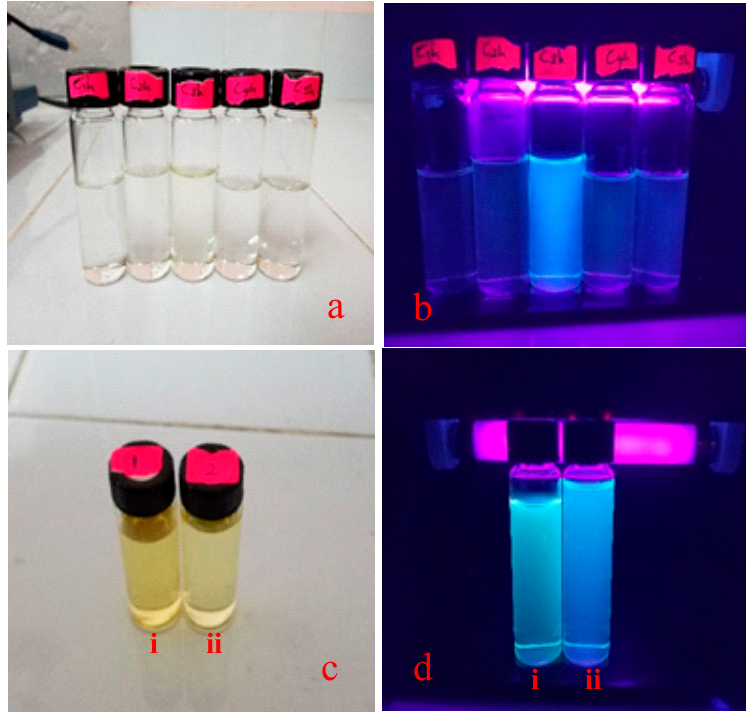
Figure 3. Effect of time of synthesis on pristine CDs under ( a ) normal light and ( b ) UV light; ( c ) (i) CDs-L-Ph (ii) CDs-EDA under normal light; ( d ) (i) CDs-L-Ph (ii) CDs-EDA under UV